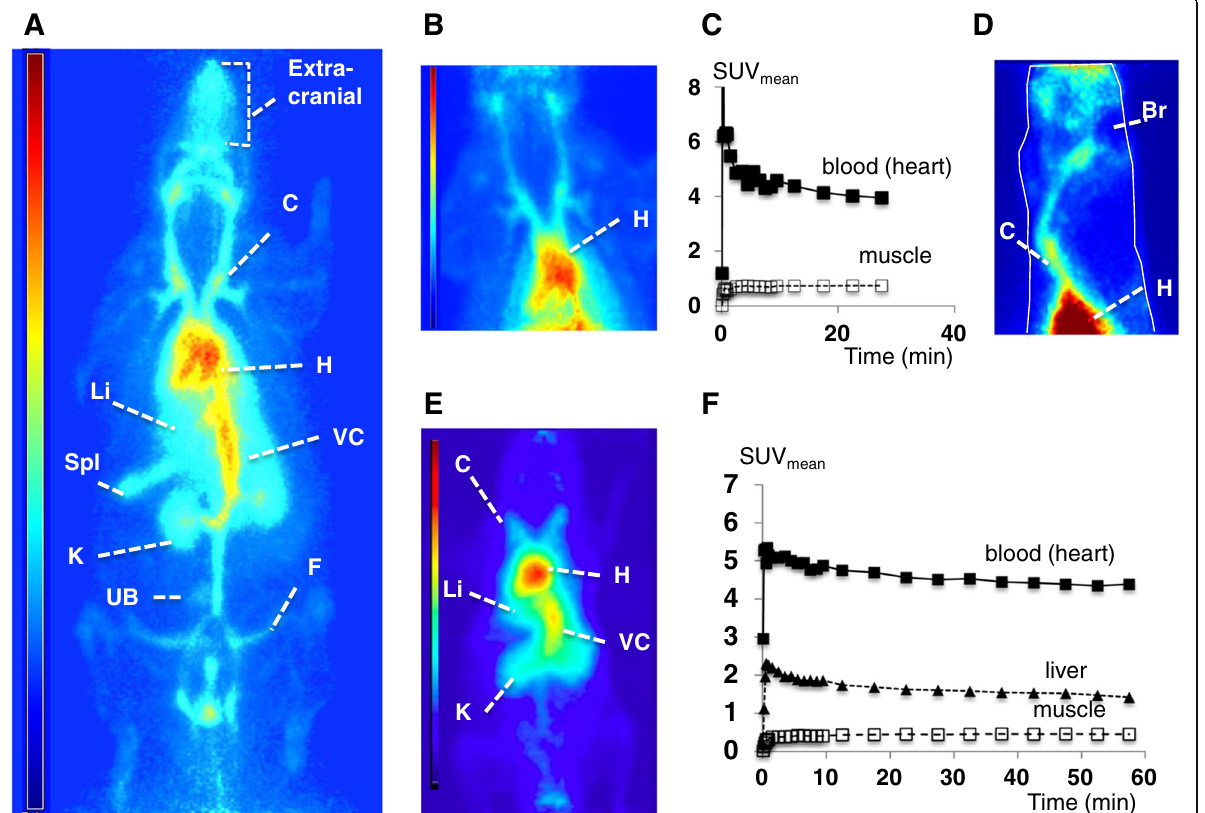
Fig. 3 In vivo distribution of radioactivity after i.v. injection of [ 68 Ga]ABY-028. a Coronal view of the whole body of a Sprague-Dawley rat; constant bed motion acquisition during 0 – 45 min. b Coronal view of the thorax of a NIH-Foxn1mu rat; fixed bed acquisition 0 – 30 min. c Time activity curves (TACs) of the mean standard uptake values (SUV mean ) from regions in the rat in b . d Sagittal view of the head, neck, and upper thorax of the rat in b ; fixed bed acquisition during 34 – 64 min. e Coronal view of the whole body of a SCID mouse; fixed bed acquisition during 0 – 60 min. f TACs from regions in the mouse in e . Br, brain; C, right jugular vein ± common carotid; F, femoral vessel; H, heart; K, kidney; Li, liver; Spl, spleen; UB, urinary bladder; VC, vena cava ±